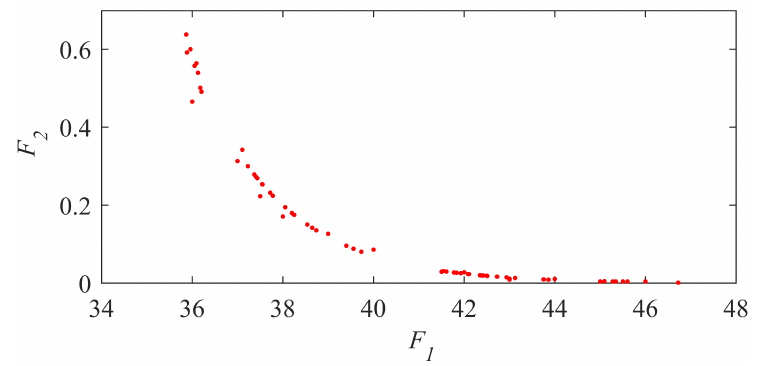
Figure 11. IEEE 39 bus test system: a multiobjective approach based on Pareto optimal